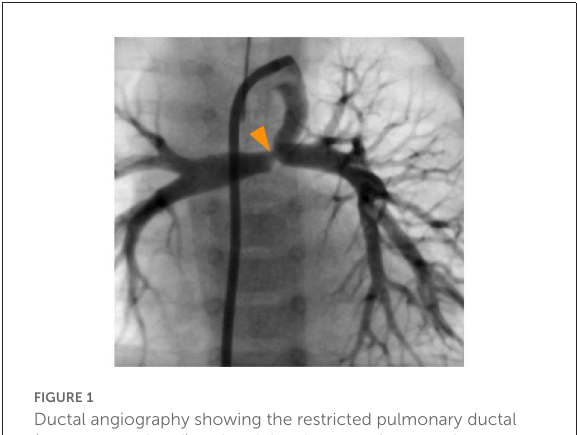
FIGURE1 Ductal angiography showing the restricted pulmonary ductal (orange arrowhead) end and the absence of connection between the branch pulmonary arteries and the pulmonary artery